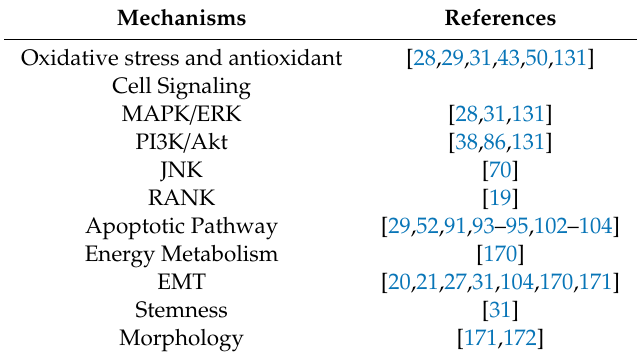
Table 2. Current research reporting cellular the mechanisms of the FSS-associated alteration of breast cancer cells applying in vitro and in vivo